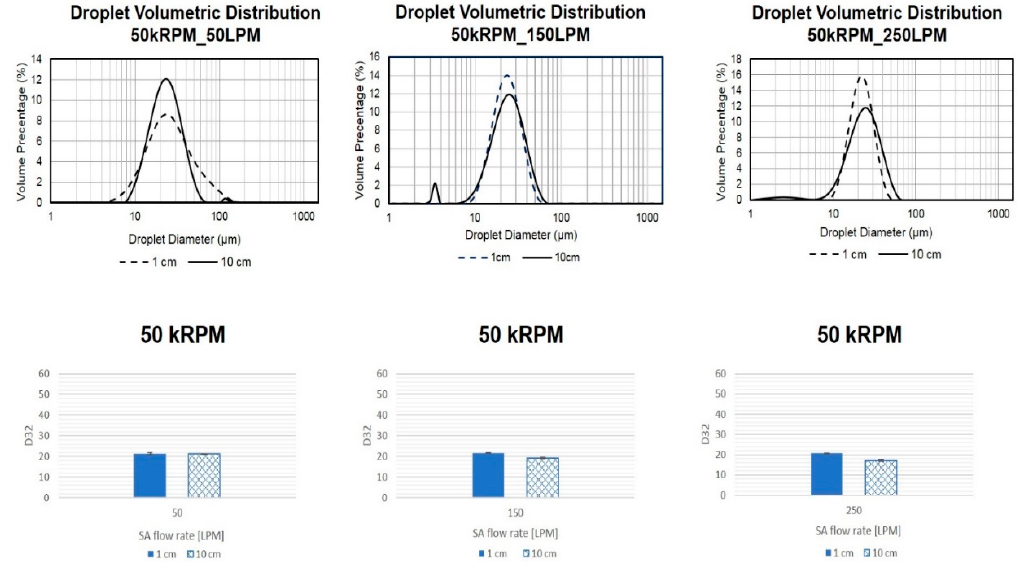
Figure 14. Droplet size volumetric distribution and mean Sauter diameter at two downstream locations downstream at 50,000 RPM cup rotational speed with varied SA flow rates.